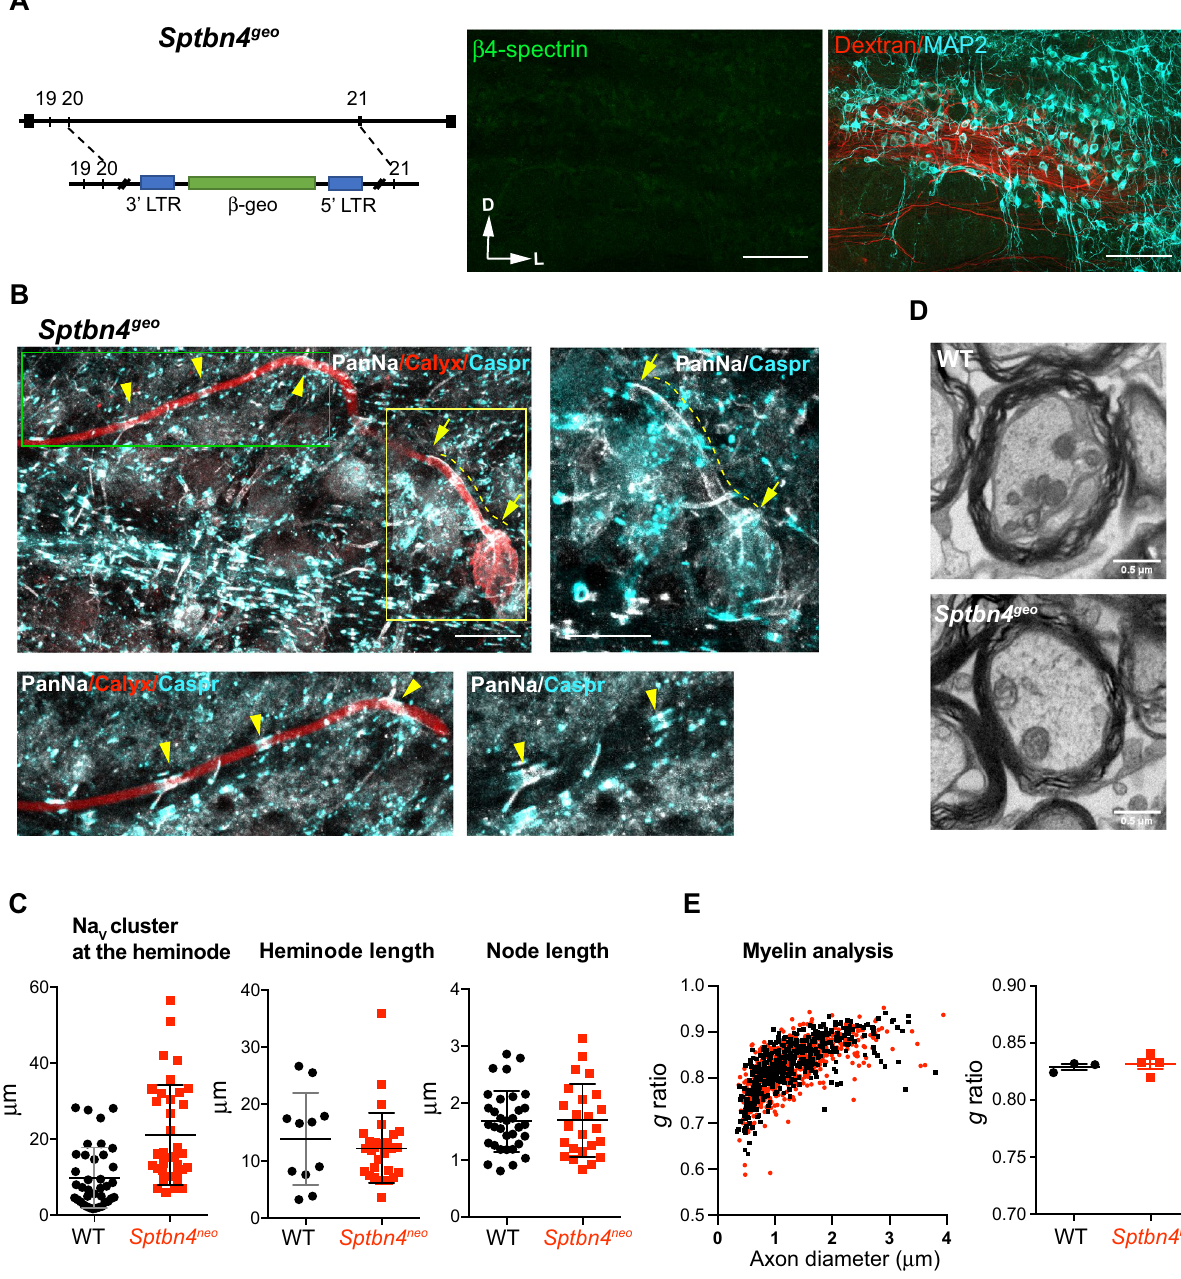
Figure 2. Loss of β4-spectrin impairs Na v clustering at the heminode in myelinated axons. ( A ) (Left) Schematic of the Sptbn4 locus in Sptbn4 geo mice, the gene trap insertion of Rosaßgeo is between exons 20 and 21. (Right) Image of the MNTB from Sptbn4 geo mouse (at P25) with axon projections labelled with Dextran (red). MNTB principal neurons were labelled with anti-MAP2 (cyan) and anti-ß4-spectrin antibody (green). Scale bar, 100 µm. ( B ) The calyx of Held terminal of Sptbn4 geo mouse (at P17) was dye-filled during whole-cell recording, then post-immunostaining with anti-NaPan antibody (gray) and anti-Caspr (cyan). (Top right) The crop image of box area (yellow). Arrows and dotted lines indicate the edges and length of Na channel expression in the heminode, respectively. (Bottom left) Magnified image of the calyx (green box in Top left). Yellow arrowheads indicate Na v channels at nodes (gray), which flanked with Caspr at paranodes (cyan). Scale bar, 20 µm. ( C ) Summary of node length (µm), Na v cluster size, (µm) and heminode length (µm). Values are means ± S.D., *** p < 0.001, Mann–Whitney U test. ( D ) Myelinated axon bundle images of WT and Sptbn4 geo auditory brainstem (at P25). Scale bar, 0.5 µm. ( E ) (Left) Distribution of g ratio (inner diameter of axon divided by outer diameter of the same axon) as a function of inner axon diameter (µm). Dots indicate values from individual axons, n = 3 WT mice (in black), n = 4 Sptbn4 geo mice (in red). (Right) Summary of g ratio of WT and Sptbn4 geo mice, values represent means per animal ±